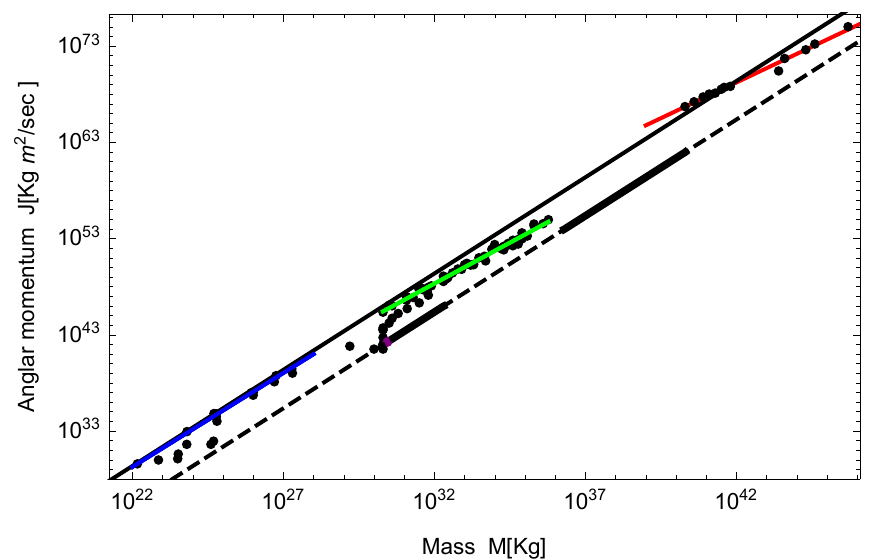
Figure 1. The angular momentum of various astronomical objects is shown [19–21]. They roughly M 2 , κ ≈ 10 4 (black solid line) on the whole. According to this figure, astronomical scale as J = κ G c objects are divided into three classes: dust(metal), gas(non-metal), and DM, from small to large scales. Each of them locally scales as J ∝ M γ where γ ≈ 1.95,1.70,1.48, respectively, represented as blue, green, and red